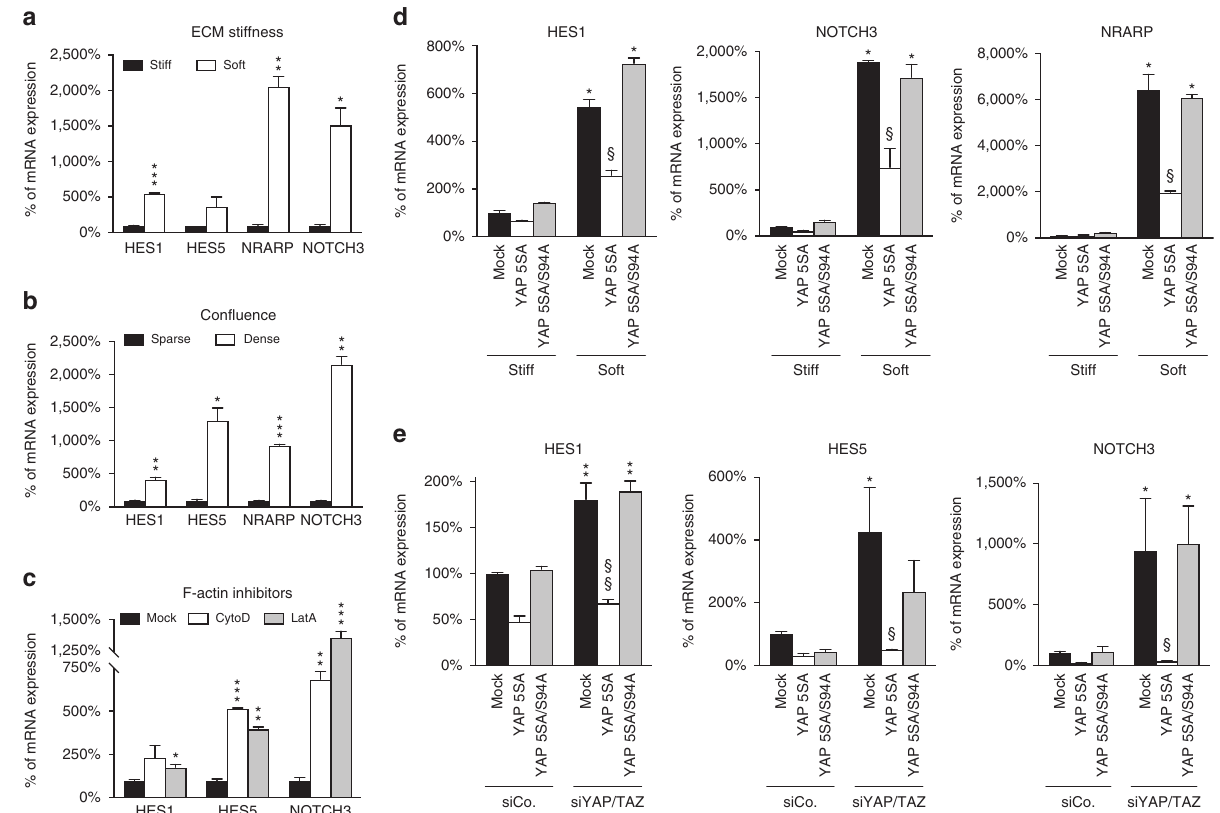
Figure 4 | YAP/TAZ regulate epidermal SC differentiation through Notch inhibition. ( a , b ) Mechanical forces regulate Notch signalling. nHEK cells were plated either on fibronectin-coated plastic dishes (stiff) and fibronectin-coated 1kPa polyacrylamide hydrogels (soft) ( a ) or at sparse and dense culture conditions ( b ). After 24 ( a ) or 48h ( b ), cells were harvested and analysed by qRT–PCR for the expression of the Notch target genes HES1 , HES5 , NRARP and NOTCH3 . For each gene, data were normalized respectively to the stiff ( a ) or the sparse ( b ) condition (black bars). ( c ) F-actin-targeting drugs activate Notch signalling. nHEK cells treated for 24h with control vehicle (Mock), 0.8 m M latrunculin A (LatA) or 2.5 m M cytochalasin D (CytoD) were analysed by qRT–PCR for the expression of the Notch target genes HES1 , HES5 and NOTCH3 . ( a – c ) Bars represent mean þ s.d. (* P o 0.05, ** P o 0.01, *** P o 0.001 compared to the respective stiff ( a ), sparse ( b ) or Mock ( c ) controls; Student’s t -test). ( d , e ) YAP/TAZ activity regulates Notch signalling. ( d ) nHEK cells infected with the empty vector (Mock) or with the indicated siRNA-insensitive doxycycline-inducible lentiviral YAP constructs were plated either on stiff or soft ECM substrates, as in Fig. 2f. Data were normalized to the Mock-infected cells plated on stiff. Bars represent mean þ s.d. (* P o 0.0001 compared to the Mock-infected cells on stiff, y P o 0.0001 compared to the Mock-infected cells on soft; two-way analysis of variance (ANOVA)). ( e ) nHEK cells infected as in d were transfected with control (siCo.) or YAP/TAZ siRNAs (siYAP/TAZ), and 8h posttransfection, cells were treated with doxycycline for 40h. Cells were analysed by qRT–PCR for the induction of Notch target genes. Data were normalized to the Mock-infected cells transfected with siCo. Bars represent mean þ s.d. (* P o 0.001, ** P o 0.0001 compared to Mock-siCo; y P o 0.001, yy P o 0.0001 compared to the Mock-siYAP/TAZ; two-way ANOVA). ( a – e ) See Methods section for reproducibility of